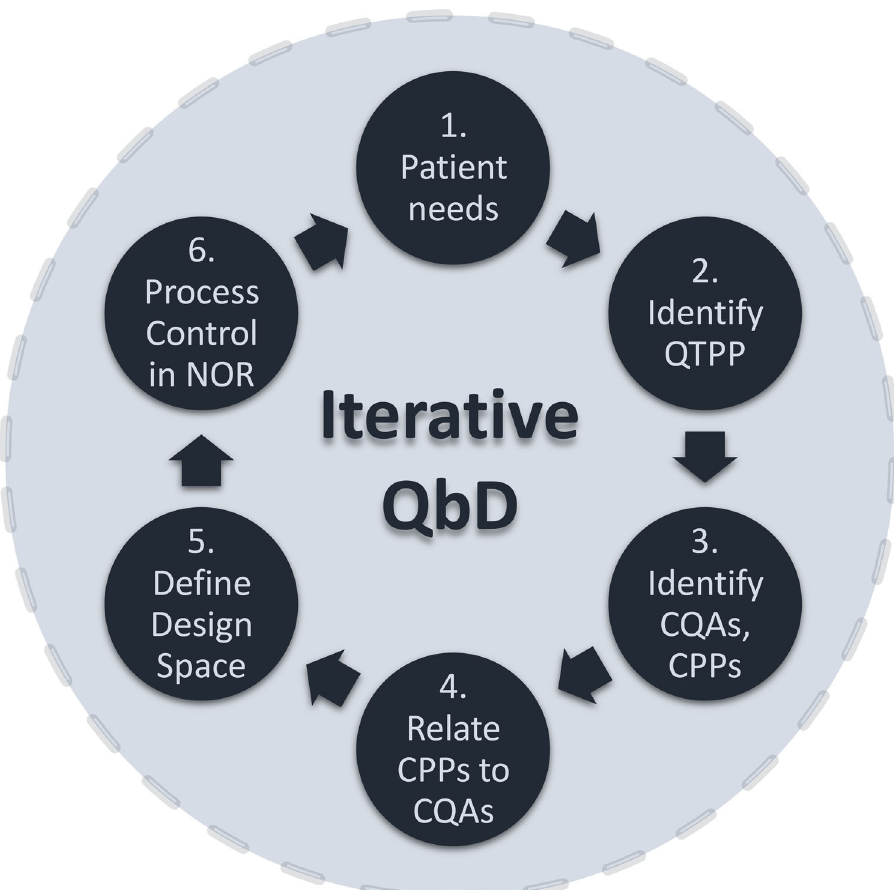
Fig. 1 Quality ‐ by ‐ design (QbD) framework development cycle. The QbD development cycle starts with identifying the needs of the patients and from there the Quality Target Product Pro fi le (QTPP) is determined. Based on the QTPP, the critical quality attributes (CQAs) of the product and their ranges are determined using a risk assessment scoring 15 , taking into account clinical and non ‐ clinical data, for both product safety and ef fi cacy. Next, based on understanding how the production process unit operations impact the product CQAs, the critical process parameter (CPP) ranges are de fi ned. From this product-process understanding, mathematical relations between CPPs and CQAs are established, thus obtaining a mathematical model of the vaccine production process at the unit operation level. This model is then used to identify the ranges of CPPs which yield the desired CQAs. From these CPP ranges, the design space can be created and therein a sub-space termed the normal operating range (NOR) is de fi ned. The production process can be operated in NOR also by adapting the QbD bioprocess model for advanced process control, using model predictive control which takes in real ‐ time measurement data from the production process. The “ digital twin ” based automation in the NOR allows for real-time optimisation of the production process which follows current good manufacturing practices (cGMP) 49,50 ; manufacturing products for the patients ’ needs at consistently high quality. Thus, the QbD framework supports both the development and operation of production processes and it follows an iterative development cycle to ensure continuous improvement through the product ‐ process life cycle 4,15